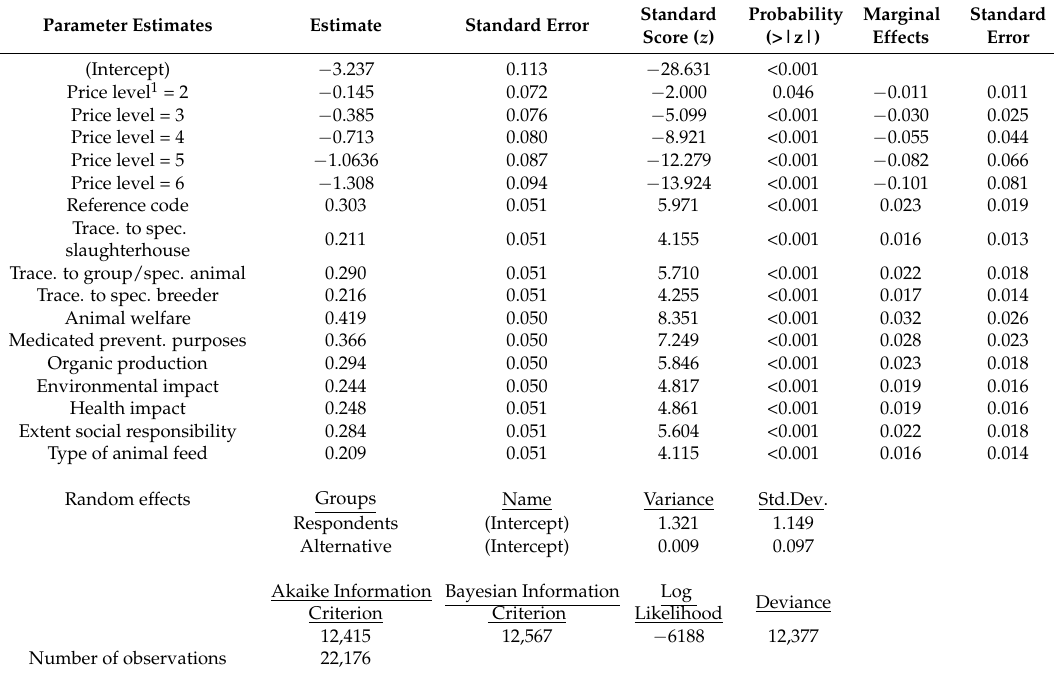
Table 7. Discrete price level with each informational attribute treated as a dummy